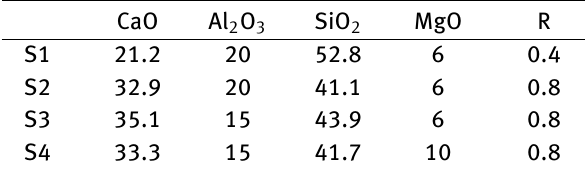
Table 3: The compositions of acid slags, %.